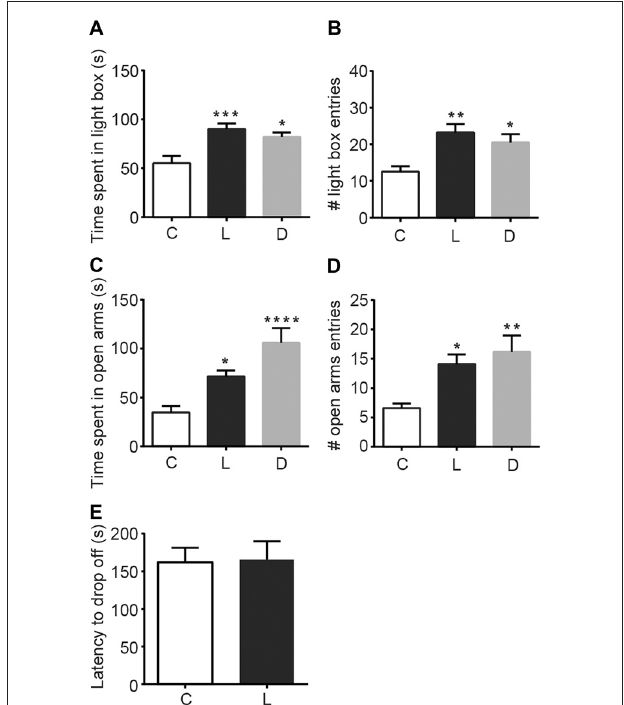
FIGURE 1 | Anxiolytic effects of linalool inhalation and diazepam injection in the Light/Dark box and elevated plus maze (EPM) tests. In the Light/Dark box test, time spent in light box (A) and number of entries to light box (B) were significantly increased in the linalool group. In the EPM test, time spent in open arms (C) and number of entries to open arms (D) were significantly increased in the linalool group. n = 10 for all groups in (A–D) . (E) Latency to drop off from accelerating rotarod. n = 6 for odorless air group and n = 7 for linalool group. (C) Mice exposed to odorless air; L, mice exposed to 200 µ L of linalool odor. (D) Mice administered diazepam intraperitoneally. Each column represents mean ± SEM. ∗ P < 0.05, ∗∗ P < 0.01, ∗∗∗ P <